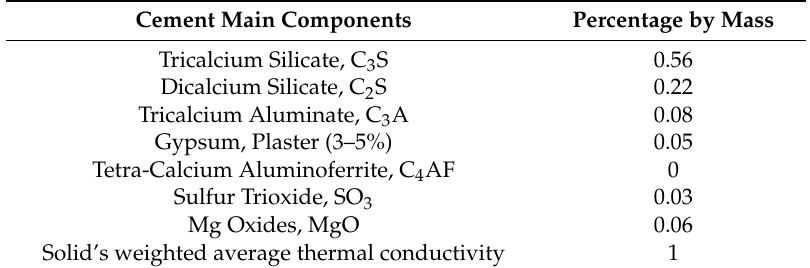
Table 2. Example of Class G (MSR) cement main components according to API 10D.